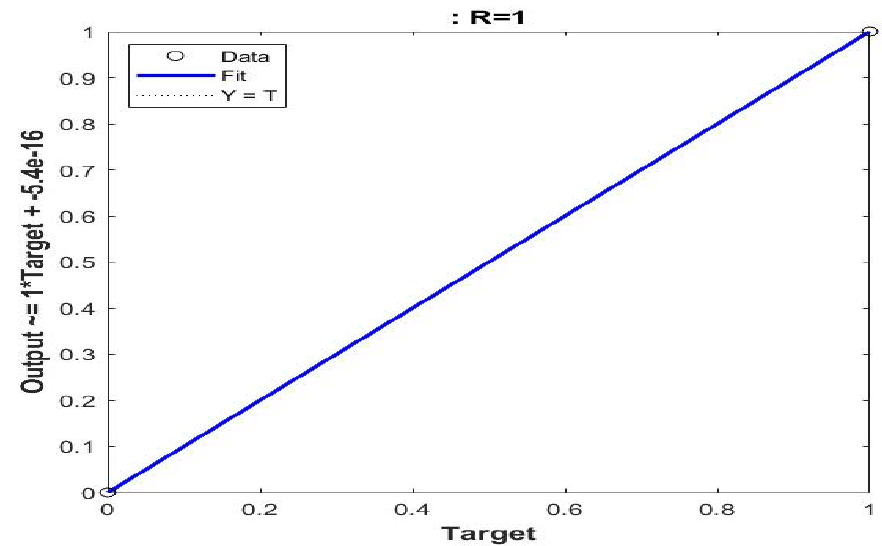
Figure 14. Regression plots for the KNN and DT methods. Table 15. Comparison of the proposed system with the system that developed the dataset.